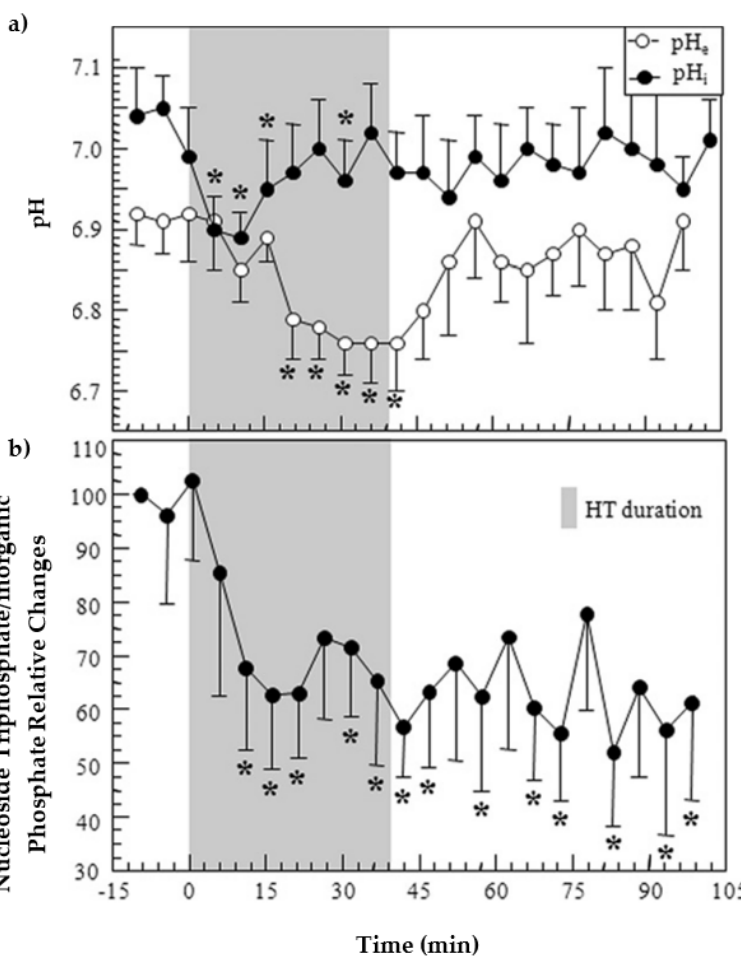
Figure 7. The changes in response to hyperthermia (HT). ( a ) The intracellular (pHi) and extracellular (pHe) pH changes in response to 45 °C hyperthermia. ( b ) The ratio of nucleoside triphosphate (NTP) to inorganic phosphate (Pi) as normalized to the baseline ratio. Please note: in vivo measurements from subcutaneously implanted 9L-gliosarcoma in Fisher rats ( n = 6), asterisk (*) indicates p less than or equal to 0.05. Image from James et al. [72].